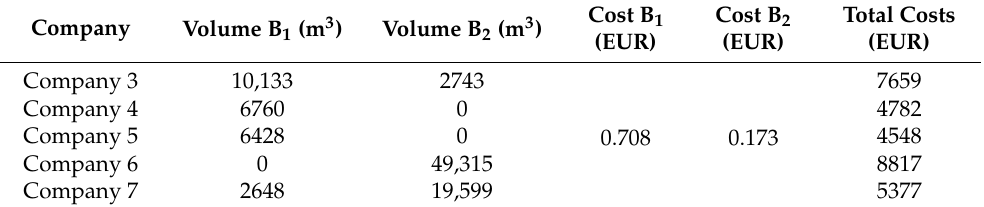
Table 11. B 1 and B 2 quality production costs for quarterly consumption for Sector